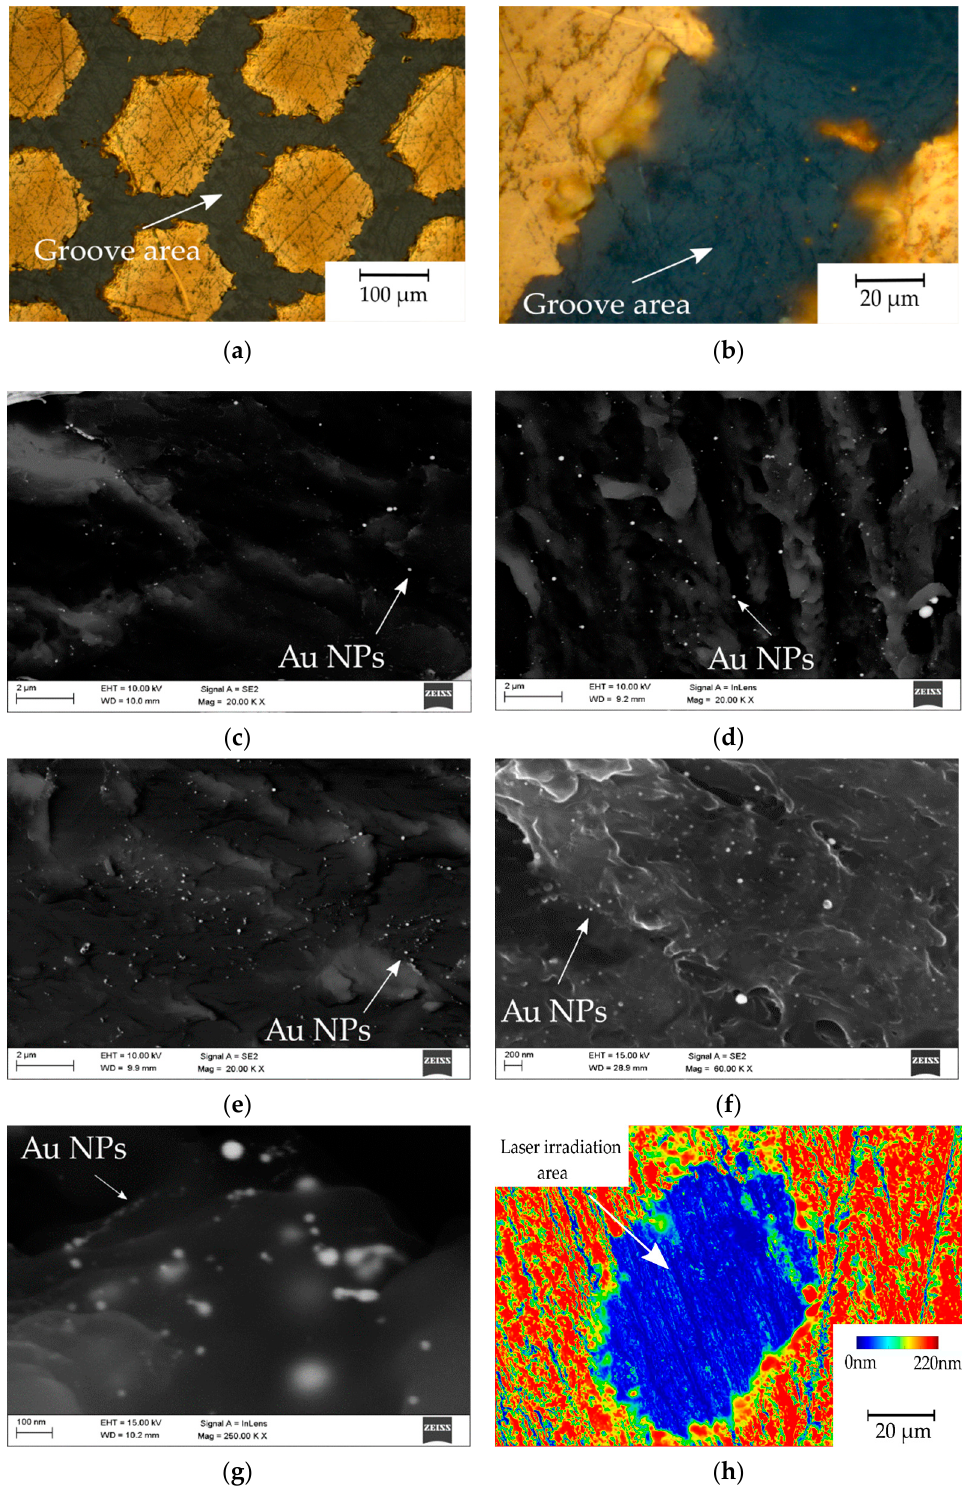
Figure 4. Gold particles inside the groove area: ( a ) 15 mW—light microscopy; ( b ) 15mW groove— light microscopy ( c ) groove 4.5 mW, SEM, SE+QBSD; ( d ) groove 15 mW, SEM, secondary electron and quantitative backscattered electron detector (SE+QBSD); ( e ) groove 16 mW SEM, SE+QBSD; ( f ) groove 16 mW SEM, SE+QBSD at higher magnification; ( g ) groove 16 mW SEM, InLens at high magnification; ( h ) confocal z-stack imaging of the 16 mW sample . NPs: nanoparticles.